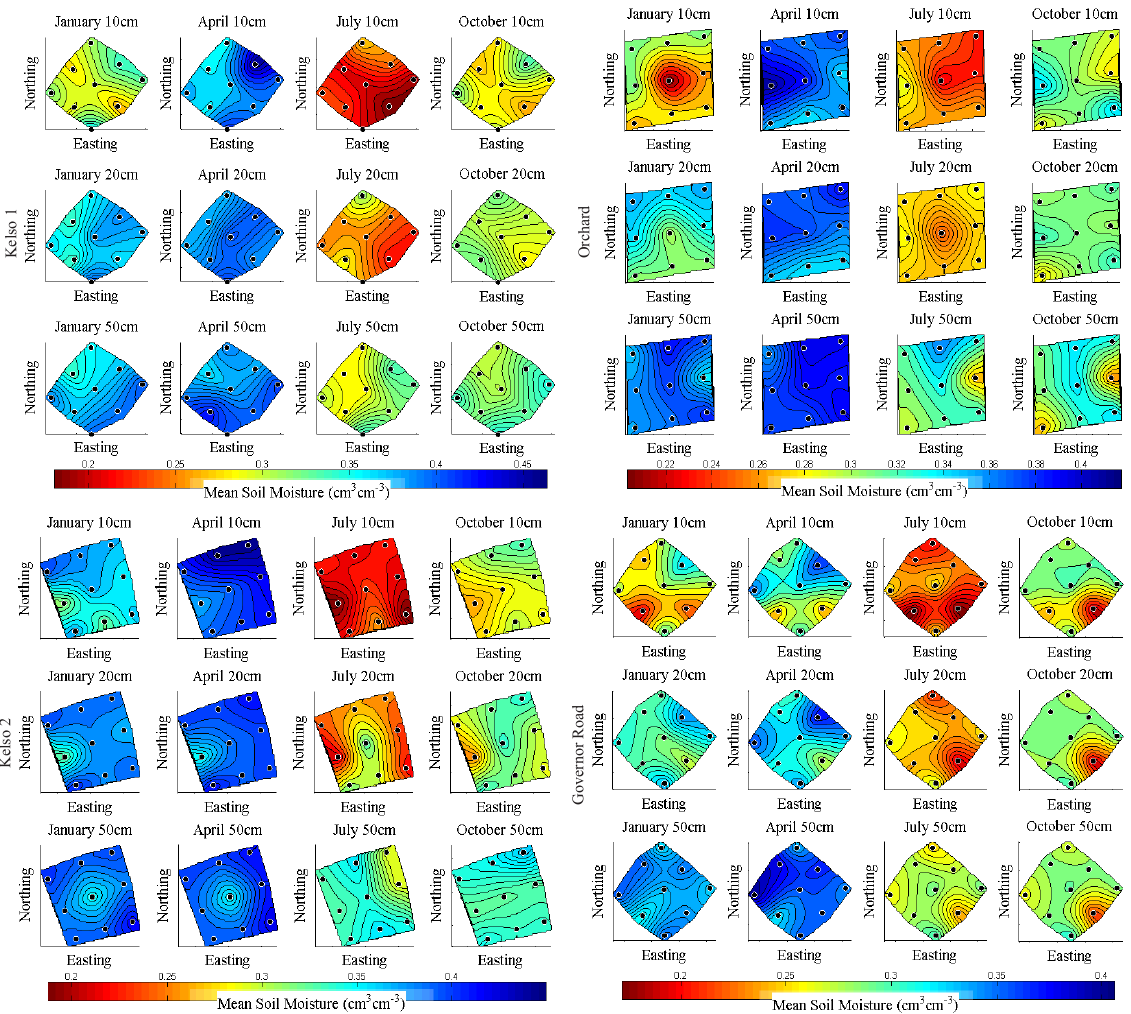
Fig. 8. Seasonal (monthly) mean soil moisture of McMaster Mesonet sites. The contour plots are created by a natural neighbour inter- polant between observed soil moisture points. A complimentary contour plot of seasonal (monthly) standard deviation can be found in the